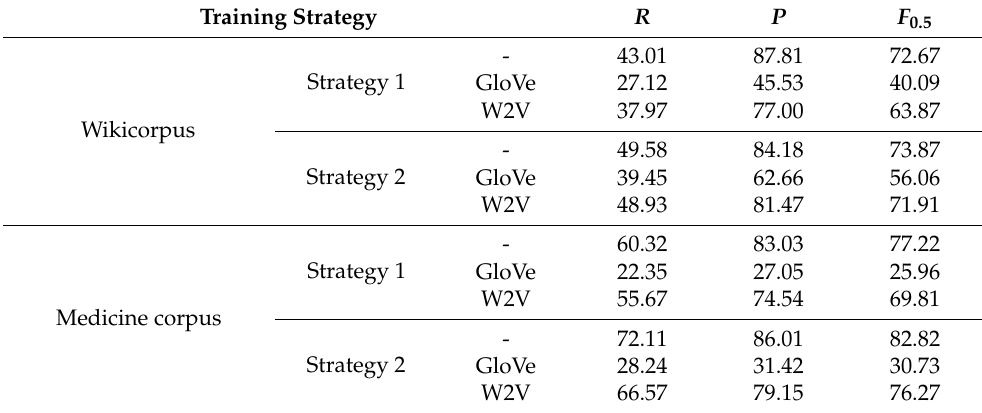
3. Evaluation of grammatical genre-number error correction . Table 11 shows the per- formance of the models on grammatical genre-number error types. In the medicine corpus, the model without pretrained embedding and the model with Word2Vec corrected 53.40% and 50.74% of sentences when trained on the training set gener- ated using strategy 1 and a precision of 78.57% and 70.71% was obtained. GloVe performance was again quite below these values, showing F 0.5 = 18.13%. The results improved after training the models on the training set generated using strategy 2.